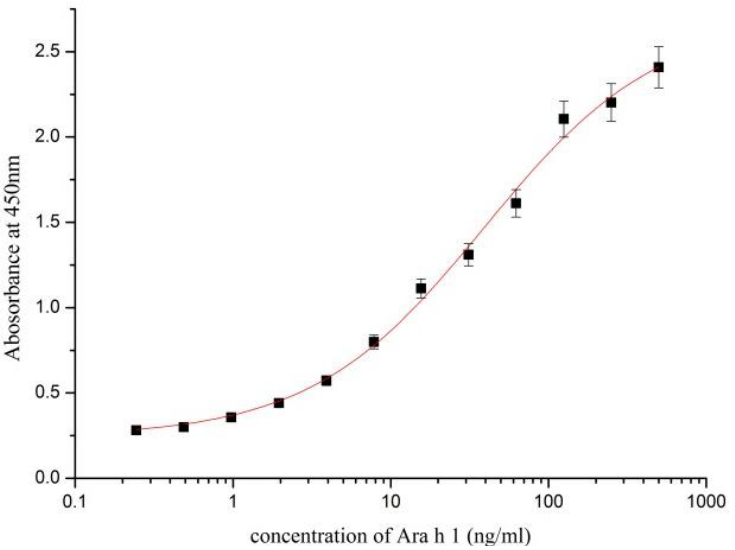
Figure 1. Calibration curve of the optimised sandwich